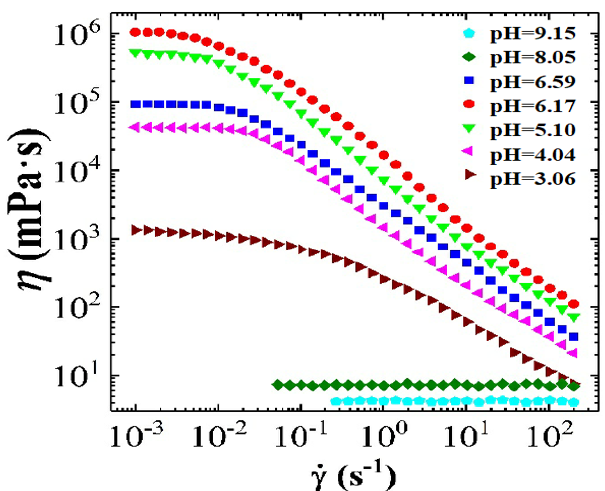
Figure 11. The steady rheological curves for the CTAB-CA based (30 mM CTAB + 15 mM MA) VES-fluid at pH range (3 < pH < 10) and at 25 ◦ C.